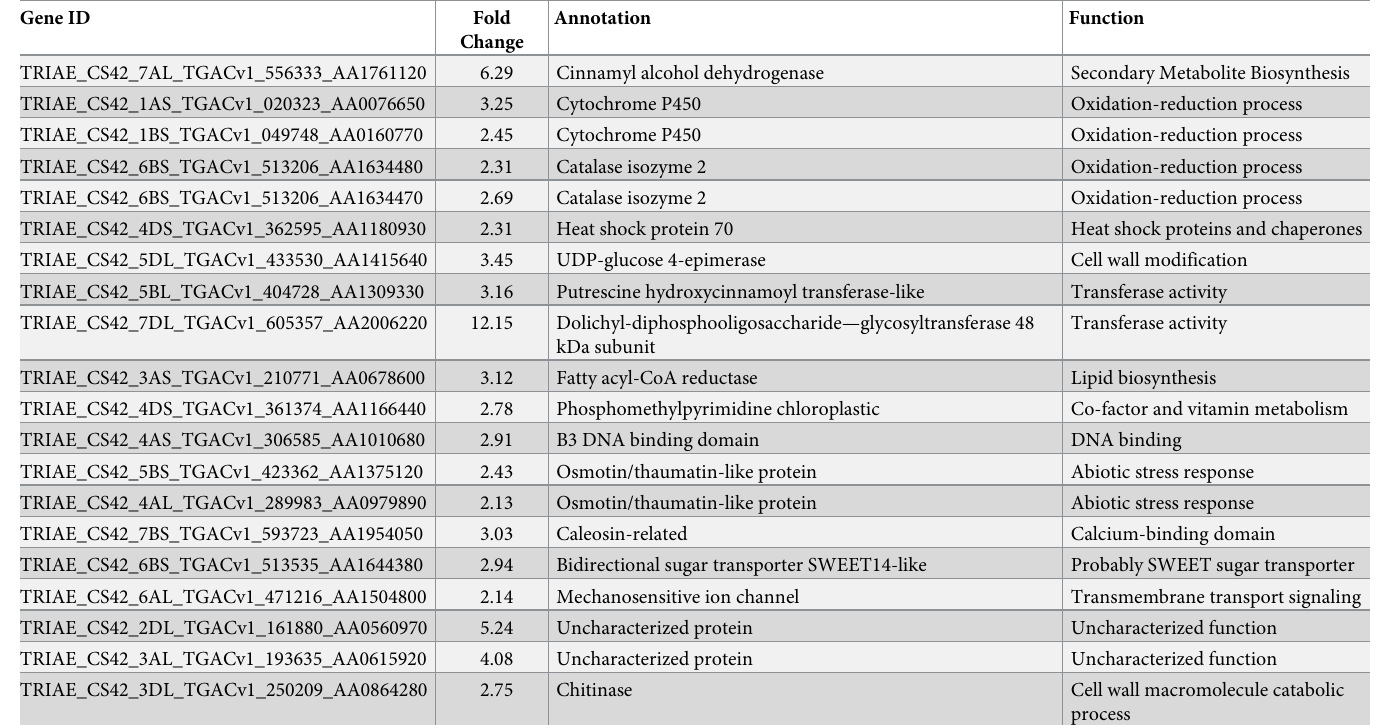
Table 2. List of specific genes which are significantly up-regulated in ED vs. EN. Gene ID Fold